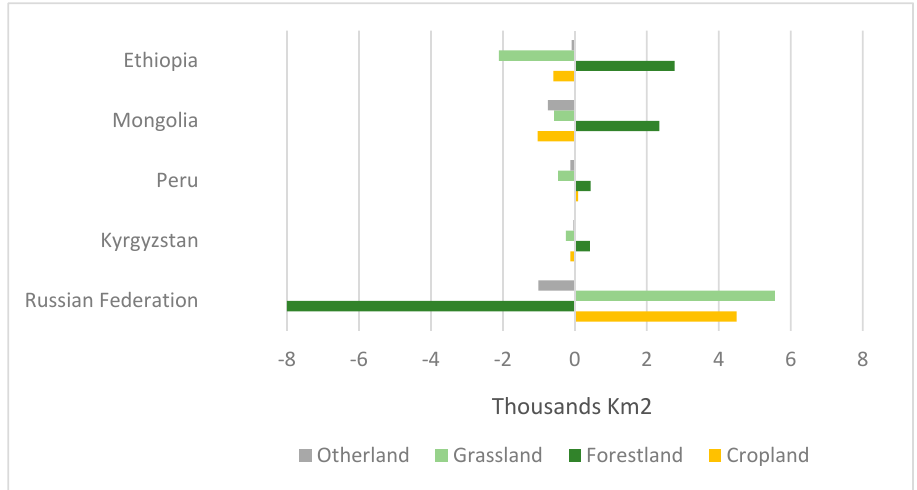
Figure 9. Land cover changes in mountain areas in selected countries experiencing increase in MGCI from 2015 to 2018.